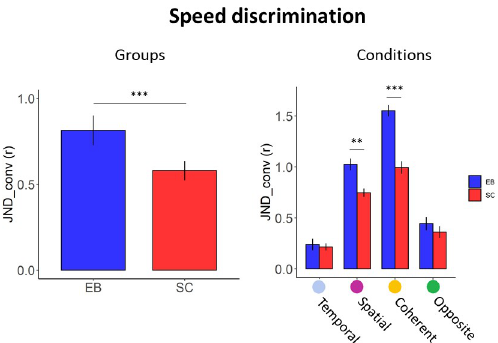
Fig 7. Group performance in the speed discrimination task: The left panel reports the average JND conv of each group. The right panel reports the average JND conv per group for each experimental condition. Error bars show standard errors. Asterisks indicate significance level: �� p < 0.01, ��� p <